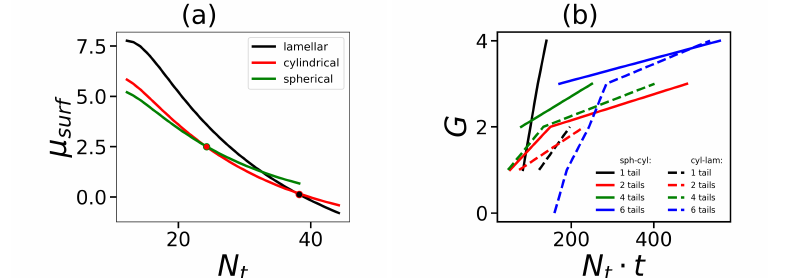
Figure 2. ( a ) Dependence of the chemical potential on the length of one hydrophobic tail (the overall number of tails t = 4). The lower the chemical potential, the more favorable that morphology. The dots on the curves show points of transitions between different morphologies (sphere-cylinder, cylinder-lamellar). ( b ) Diagrams of states of the micelle in coordinates of the overall number of segments in hydrophobic tails in the surfactant molecule N t · t and the generation number G in the hydrophilic dendron. The regions of spherical micelles and lamellar structures are above the solid and below dashed lines, correspondingly. The intermediate region corresponds to the cylindrical configuration of micelles.